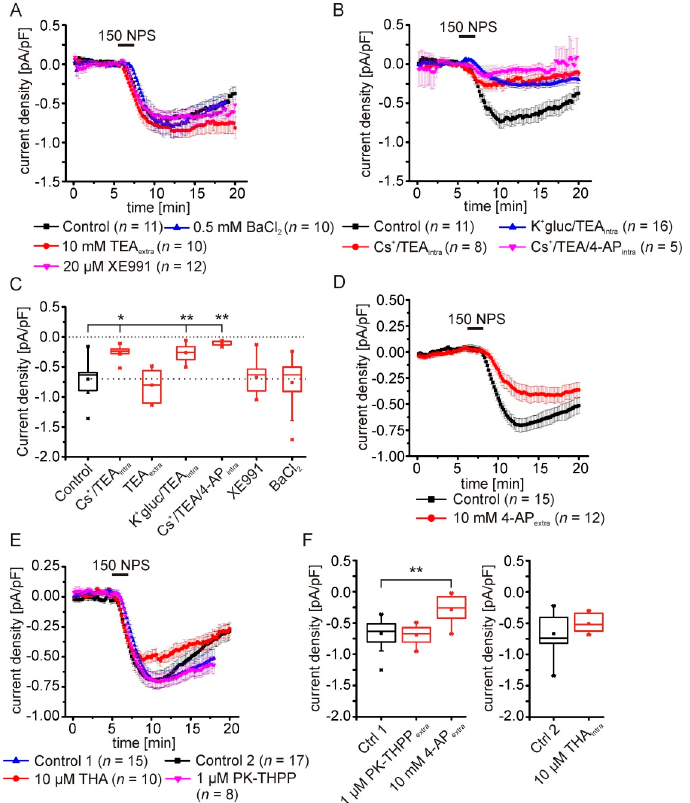
Figure 5. Pharmacological characterization of NPSR1-modulated potassium conductances. ( A ) Pharmacological characterization of NPSR1-modulated potassium Neither the time course nor the maximal amplitude of the NPSR1-mediated current elicited by 150 nM NPS are altered by 0.5 mM BaCl 2 , 10 mM extracellular TEA, or 20 µM XE991. ( B ) The NPSR1-mediated current is sensitive to intracellular recording solutions containing: K + -gluconate and 10 mM TEA (blue), Cs + -methylsulfonate and 10 mM TEA (red), and Cs + -methylsulfonate, 10 mM TEA, and 10 mM 4-AP (magenta). ( C ) Quantification of the mean current densities depicted in ( A ) and (B ). ( D ) In the presence of 10 mM 4-AP, the mean current density of the NPSR1-mediated current is significantly attenuated. ( E ) Intracellular THA (10 µM) or extracellular PK-THPP (1 µM) do not affect the NPSR1-mediated current. ( F ) Quantification of the current densities depicted in D) and E). 10 mM 4-AP, but not PK-THPP, significantly reduces the NPSR1-mediated current (one-way ANOVA: F(2,32) = 12.57; p = 9.3 × 10 − 5 ; post hoc test: 4-AP vs. ctrl 1: p = 2.5 × 10 − 4 ). Intra- cellular THA (10 µM) does not significantly affect the NPSR1-mediated current ( t -test: t = − 1.67; df = 25; p = 0.107). * p < 0.05; ** p < 0.01.